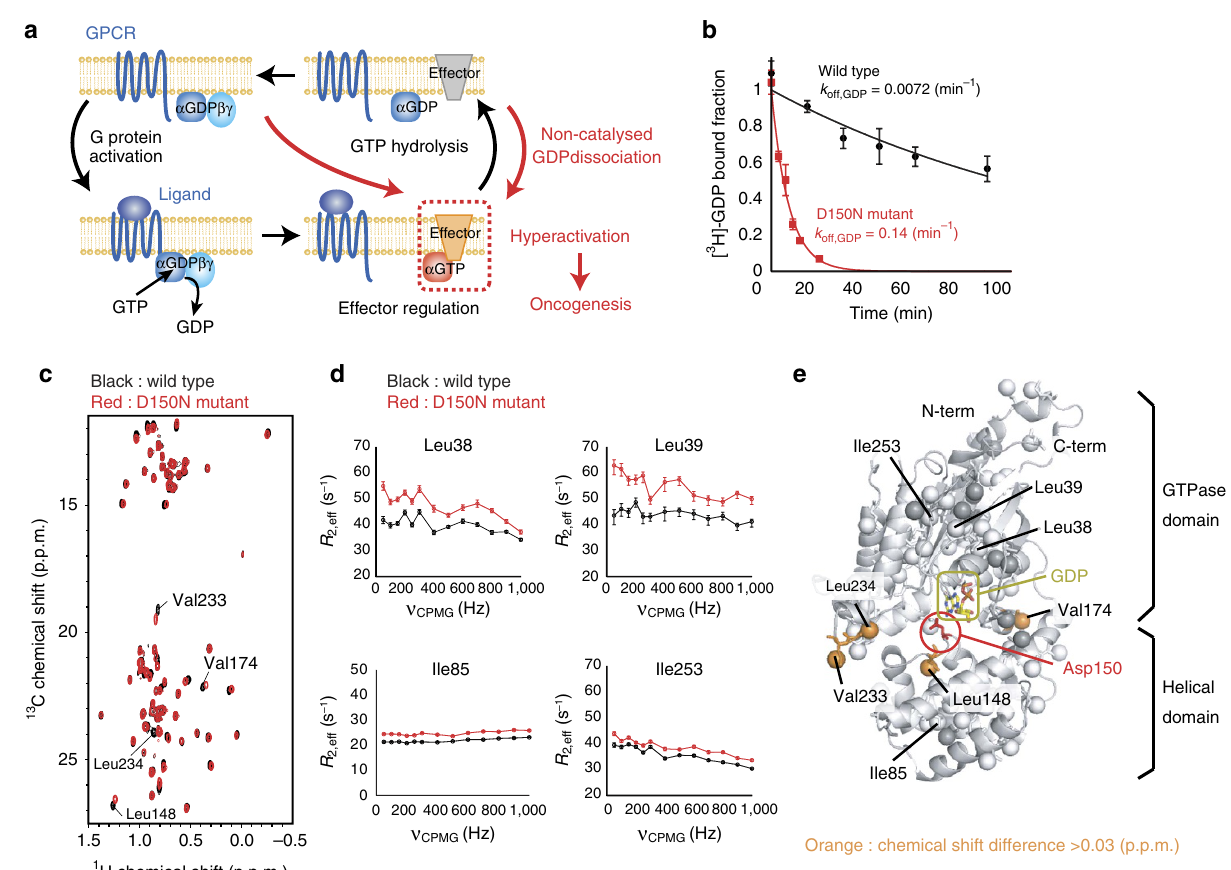
Figure 1 | Functional and structural analyses of the wild-type and mutant G a -GDP. ( a ) Proposed mechanism for oncogenesis induced by the G a mutant 9 . In cells expressing the G a mutant that shows accelerated GDP dissociation, the GDP-GTP exchange reaction is facilitated without the activated GPCR, and the fraction of G a -GTP is increased. The increased G a -GTP causes hyperactivation of the effector proteins, leading to oncogenesis. ( b ) 3 H-GDP dissociation assays of the wild-type G a and the D150N mutant. The experiments were performed at 20 (cid:2) C. Each point reflects mean ± s.e. of three independent experiments. ( c ) Overlay of the 1 H- 13 C HMQC spectra of the wild type (black) and the D150N mutant (red). The methyl groups with chemical shift differences larger than 0.03p.p.m. are shown labelled. ( d ) Results of the MQ CPMG RD experiments with the wild type (black) and the D150N mutant (red). The experiments were performed at 14.1Tesla (600MHz 1 H frequency). The error bars represent the experimental errors calculated using the equation (16). ( e ) Mapping of the methyl groups with chemical shift differences in the D150N mutant on the structure of G a -GDP (PDB ID: 1GDD) 17 . Methyl groups with chemical shift differences larger than 0.03p.p.m. are coloured orange. Methyl groups with no data are coloured grey. The methyl groups for which MQ CPMG RD results are presented (Leu38, Leu39, Ile85 and Ile253) are also shown with